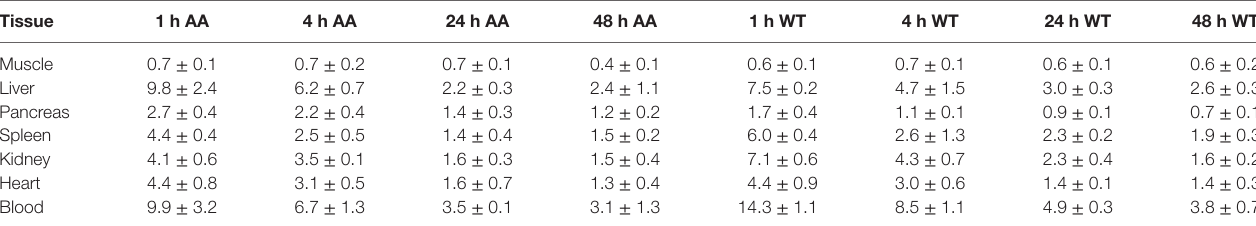
TaBle 1 | Biodistribution of 125 I-Fcp5 in AA and wild-type (WT) mice expressed as percent injected dose per gram (%ID/g). Tissue 1 h aa 4 h aa 24 h aa 48 h aa 1 h WT 4 h WT